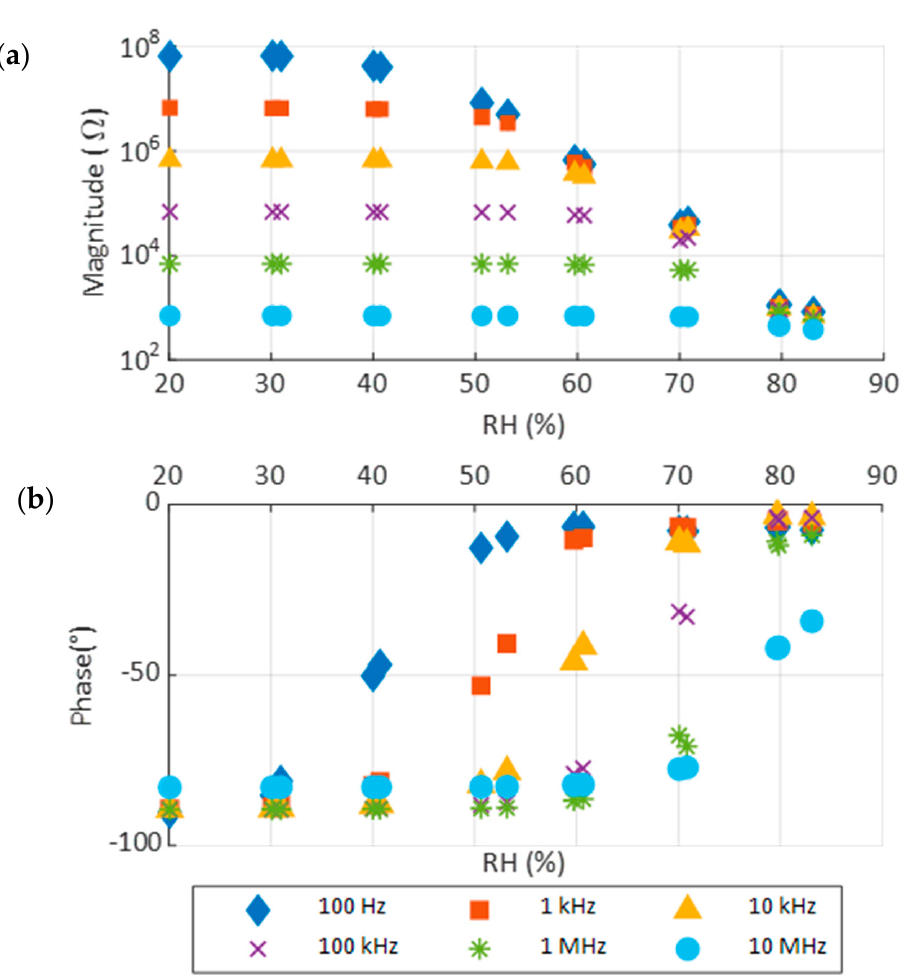
Figure 10. Impedance response towards RH at 40 °C. ( a ) Magnitude and ( b ) phase for spray-deposited Na-Pery. Table 2. Sensitivity of the sensor in the linear response for the different frequencies and range of RH of the linear phase.